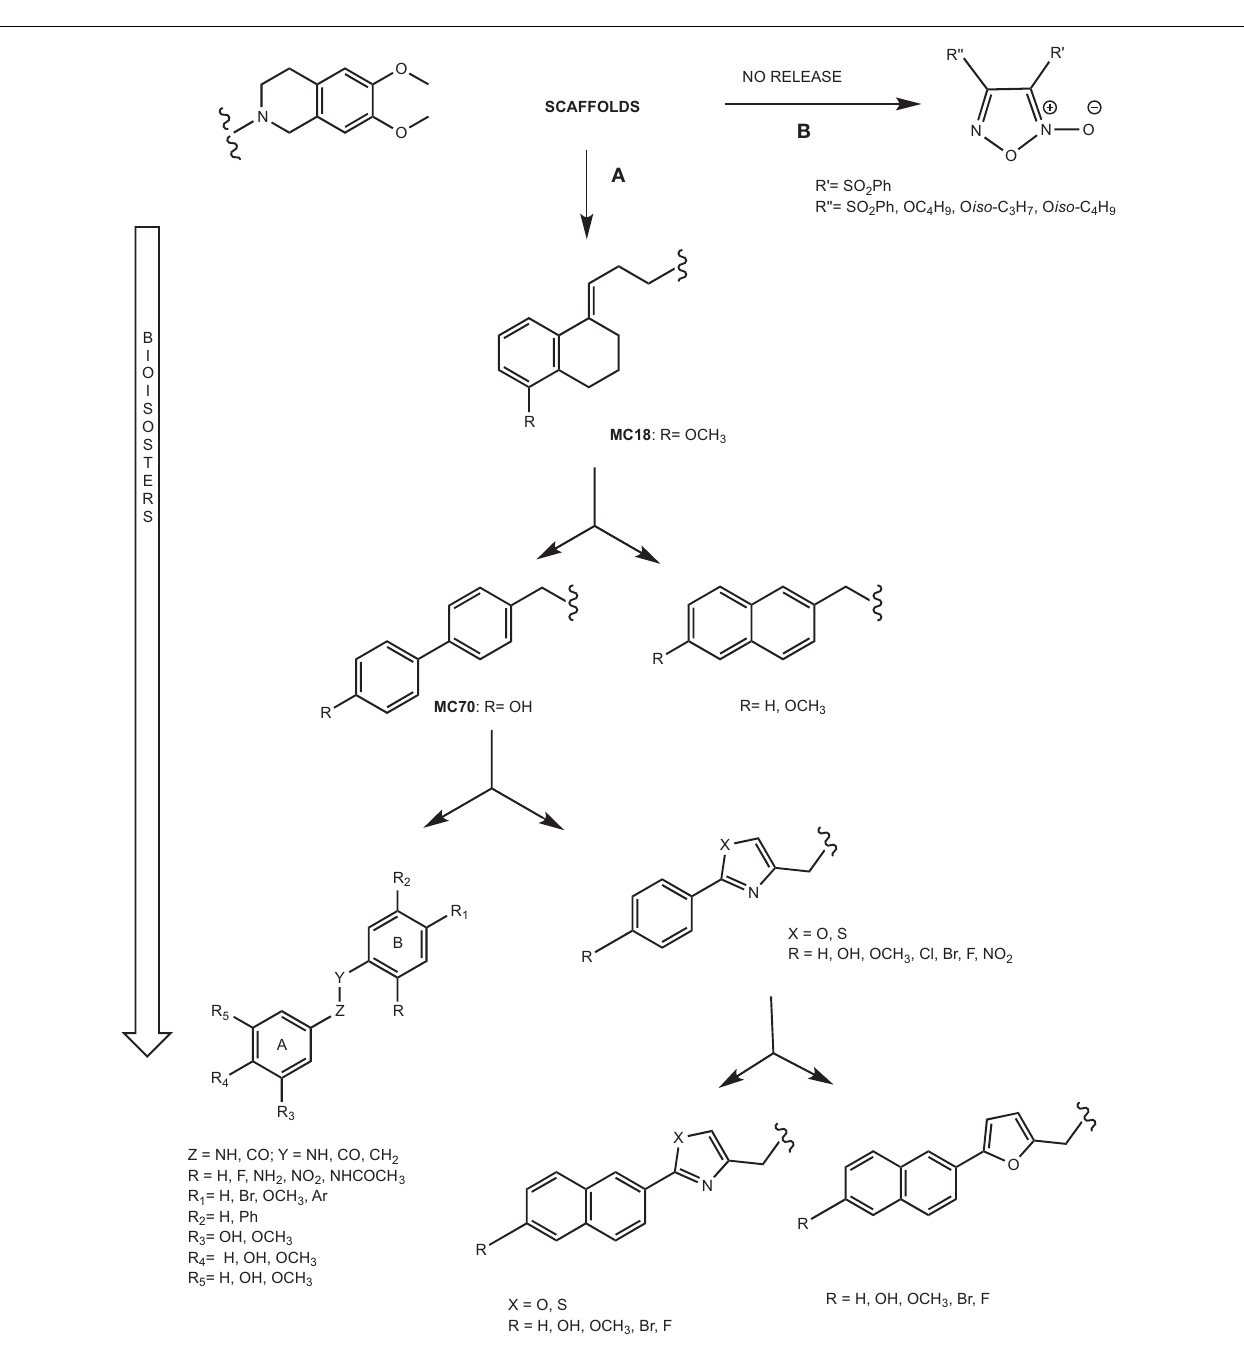
The evaluation of data suggested that, with the exception of the 4-bromo and 4-methoxy congeners, all compounds of this second set were potent and selective P-gp inhibitors. In particular, molecules bearing R = NO 2 and in R1 H or benzo[1,3]dioxol-5-yl displayed submicromolar